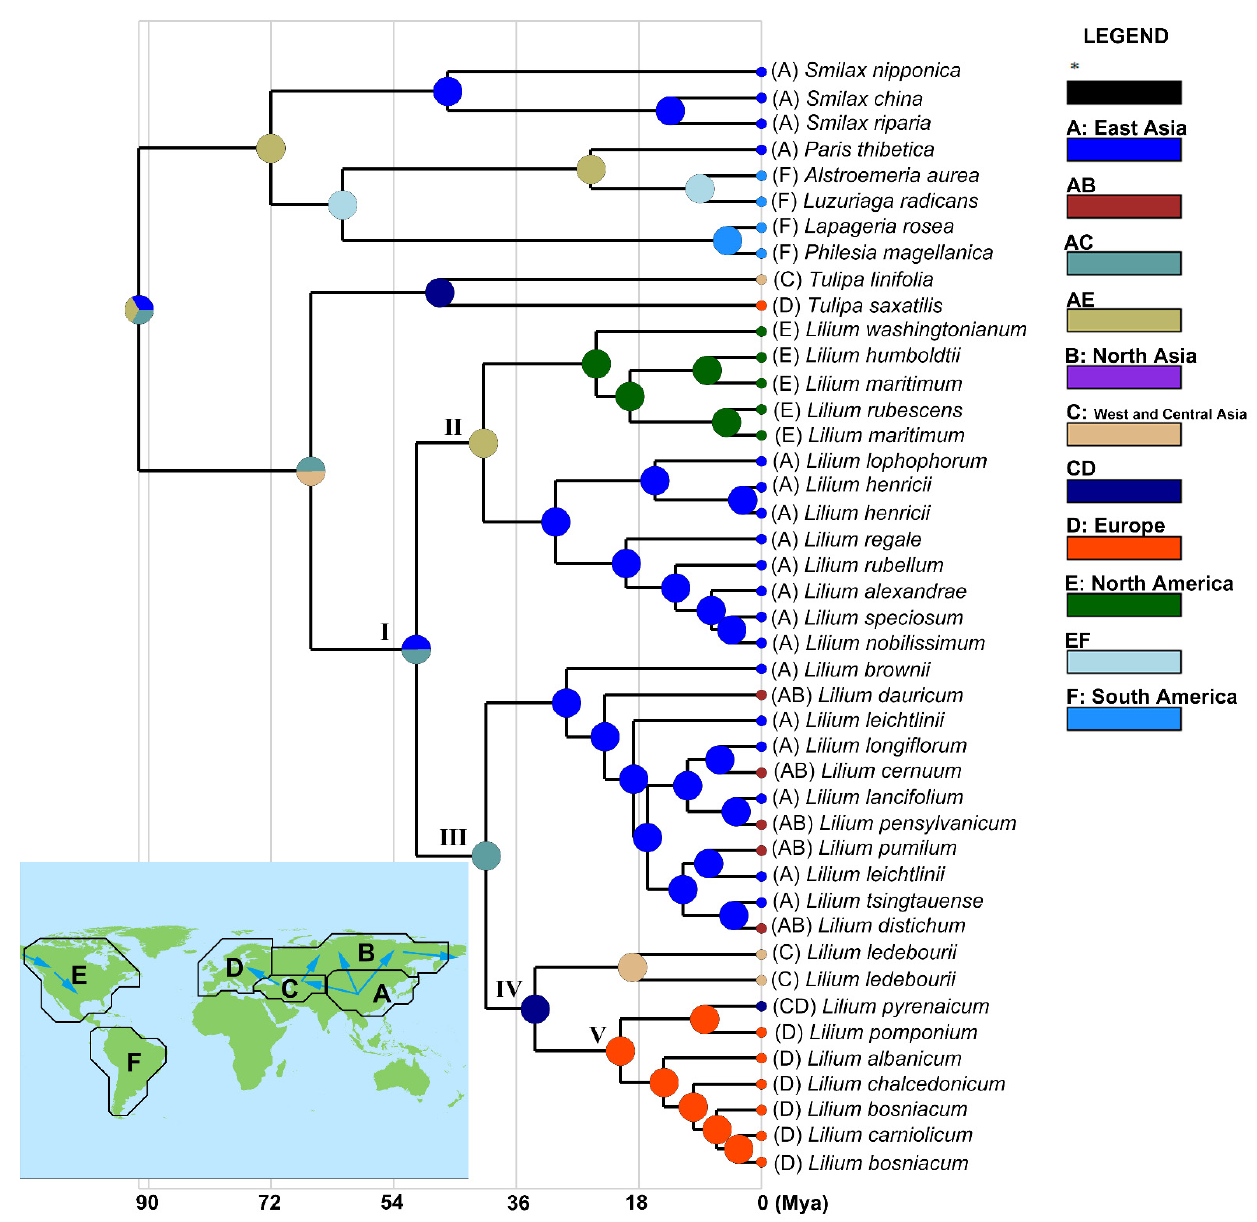
Figure 3. Divergence time estimations and the major divergence events among the Lilium species based on region combined data (ITS + matK regions) and Dispersal scenario of Lilium in the world. Pie charts depict ancestral area reconstruction probability, with the colors of pie slices defined in the legend. (The reader is directed to the web version of this article for an explanation of the color references in this figure legend).